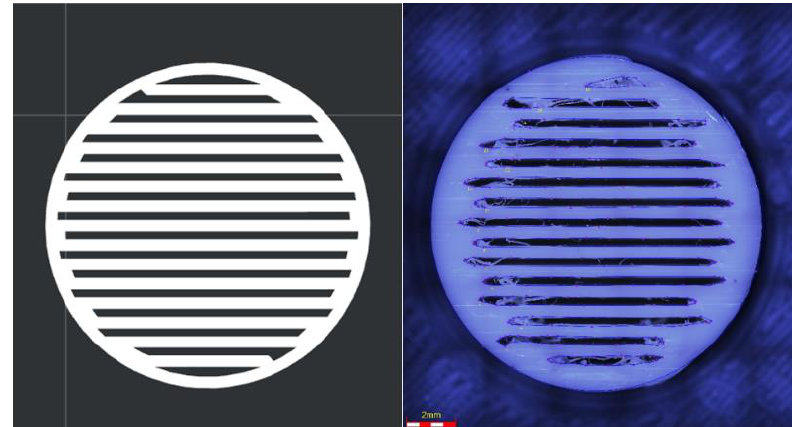
Figure 2. Comparison of the ideal, sliced, and the real, manufactured specimen for the measurement of the contact area after the tribological tests.